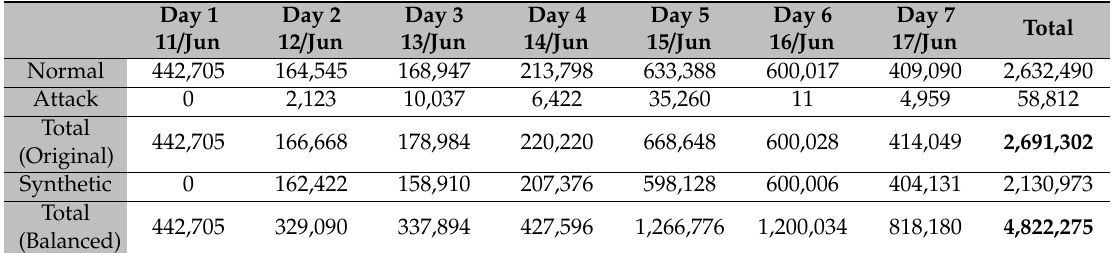
Table 5. Number of classes of instances for each day’s file of the STA2018